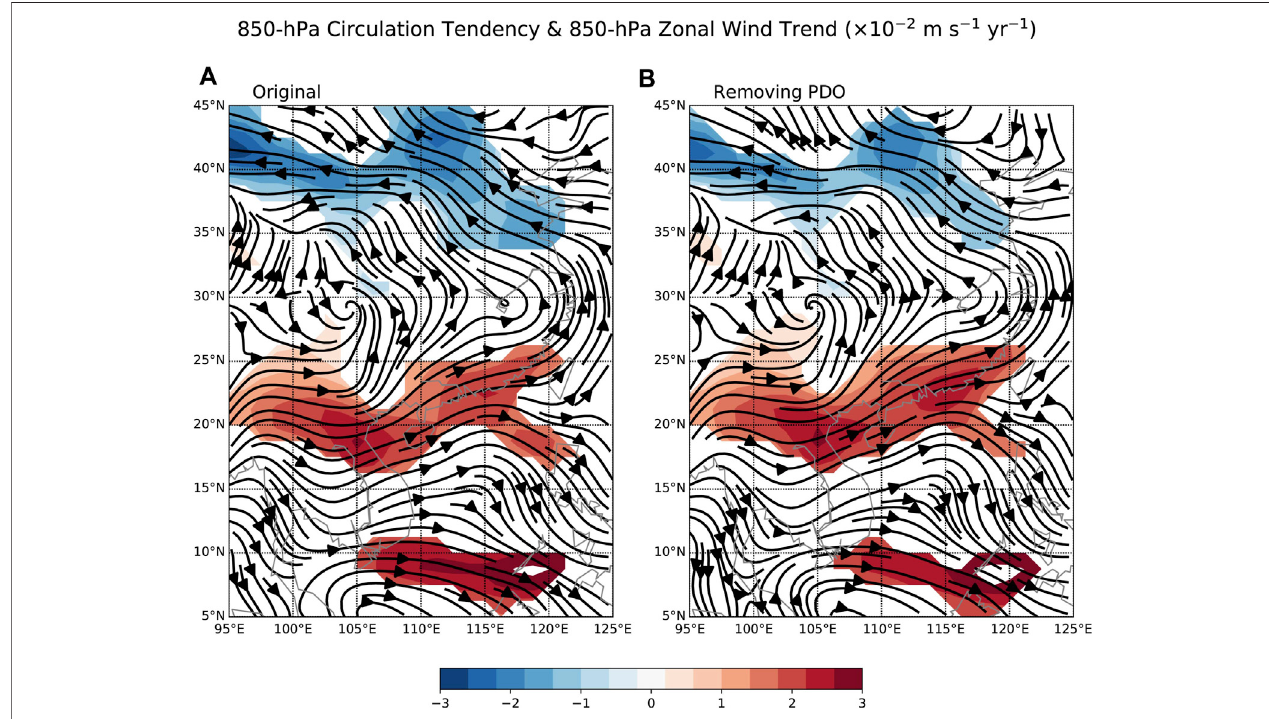
FIGURE7 | Regressed June-November 850-hPa circulation (streamlines) and 850-hPazonal wind speed (colors) from 1966 – 2018. Values in (A) areestimated by a linear regression on time. Values in (B) are obtained by a partial regression on time when removing the linear effect of the PDO index. Colored values denote 850-hPa zonal wind speed trends signi fi cant at the 0.05 level based on an F -test.